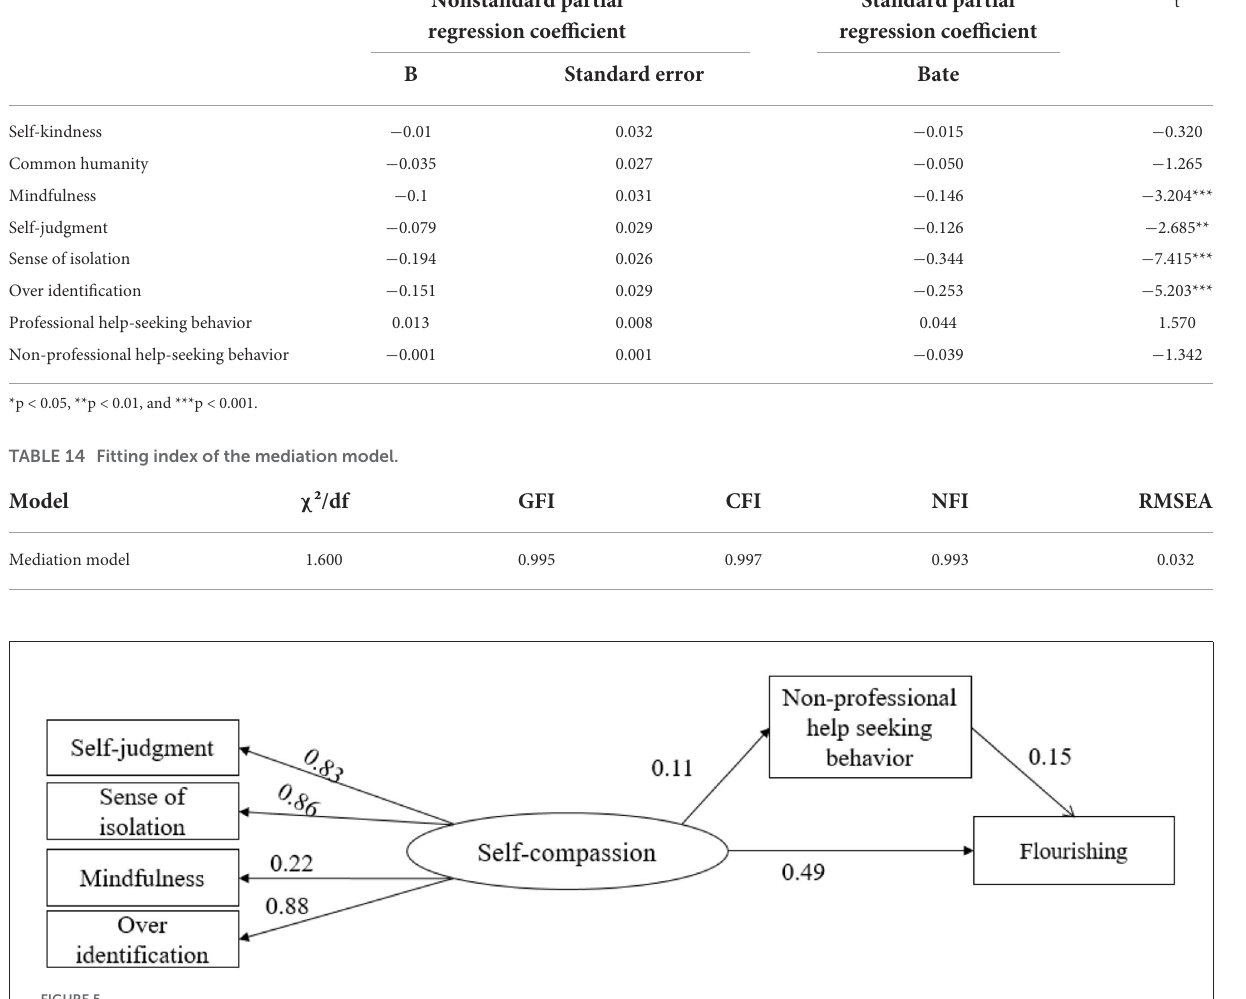
include longitudinal data or experimental methods to verify their relationships, extend to other types of master’s degrees and other geographical realities, and analyze in a factorial way to better cover the universe